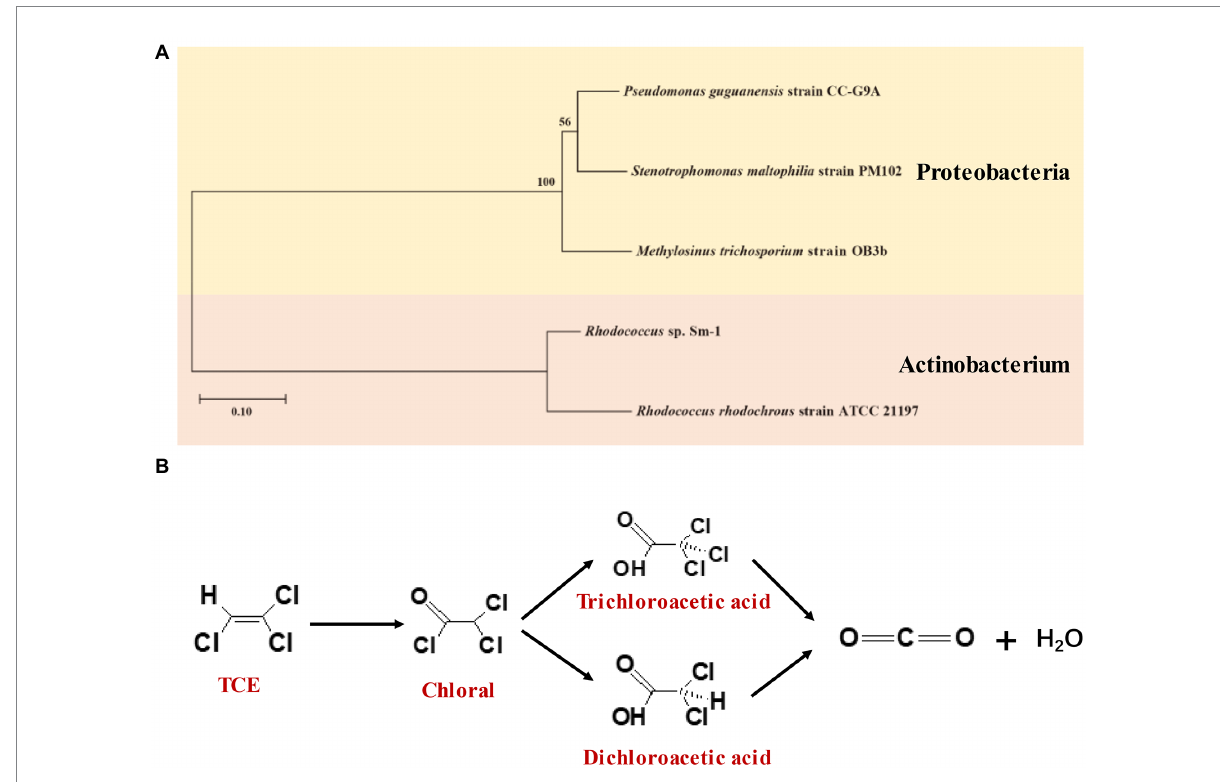
FIGURE 4 (A) Phylogenetic tree constructed based on the 16S rRNA sequences of isolated bacteria for TCE aerobic direct oxidation; (B) Aerobic direct oxidation of TCE by Pseudomonas guguanensis NR135725 [adapted from (Baskaran and Rajamanickam,